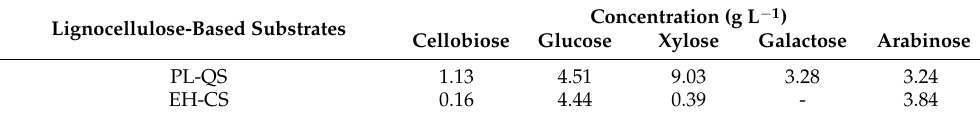
Table 2. Sugar composition of the pretreatment liquid of steam-exploded quinoa stalks (PL-QS) and the enzymatic hydrolysate of Curupa ú sawdust